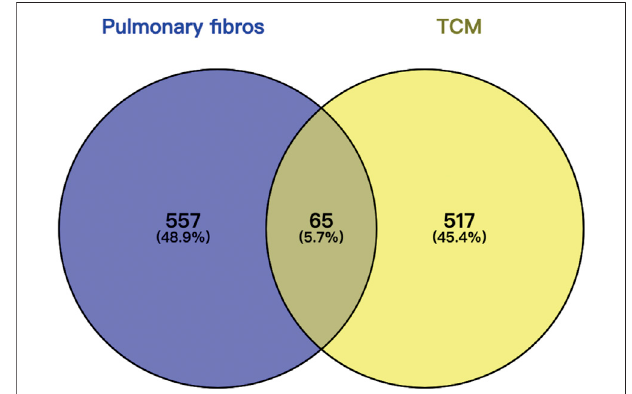
FIGURE 2 | Wayne diagram of commo gene targets of Convalescent Chinese prescription (CCP) drug therapy and pulmonary fi